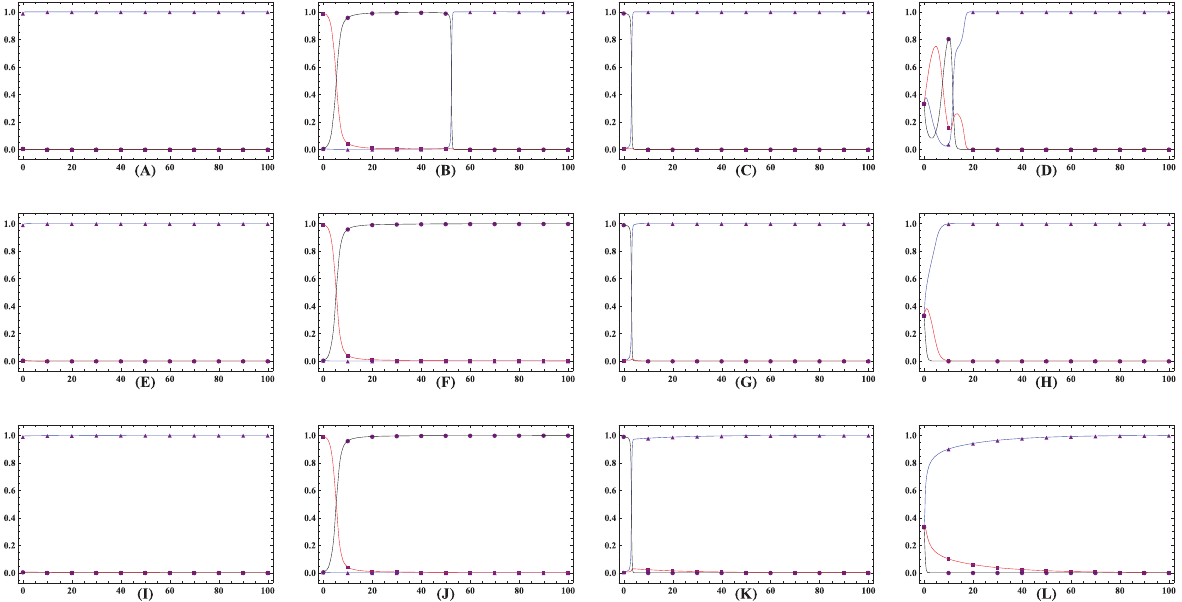
(1 3,1 3,1 3) responding to the fraction of